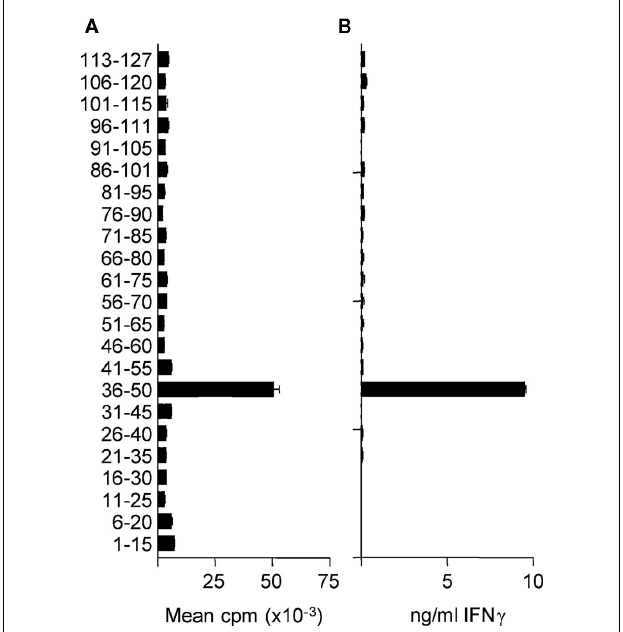
FIGURE 1 | MOG − / − T cells remain focused on MOG(35–55). MOG − / − mice were immunized with 100 μ g rMOG in CFA.Ten days later, draining LN were tested for recall responses to individual overlapping peptides as measured by proliferation (A) or IFN-y secretion (B) . Data shown are from a representative experiment of